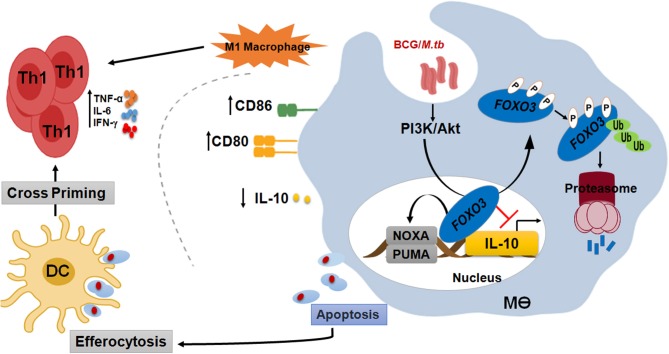
FOXO3, a signaling hub for a protective immune response against mycobacterial infection. In order to compromise host resistance, M.tb predominantly activates the pro-survival pathway PI3K/Akt to inhibit apoptosis and induce IL-10 through FOXO3 inhibition. Activated Akt will then phosphorylate the pro-apoptotic transcription factor FOXO3 at three residues, Thr32, Ser253, and Ser315, leading to its translocation to the cytosol where it is stored as a complex FOXO3/chaperone protein 14-3-3 and/or degraded by the proteasome. However, PI3K/Akt inhibition leads to activation of FOXO3, which will accumulate inside the nucleus and restrict IL-10 secretion through direct binding to its proximal promoter. Inhibition of IL-10 signaling is necessary to restore the anti-mycobacterial capacity of the host and increase the polarization of macrophage toward a proinflammatory M1 phenotype, which is crucial for the shaping of an effective Th1 adaptive response against M.tb pathogenesis. Activation of FOXO3 would also induce the expression of PUMA and NOXA, the two effectors of macrophage apoptosis. Apoptotic bodies charged with mycobacterial antigens will be ingested by the bystander dendritic cells (DC) to better cross-prime T cells. In conclusion, activated FOXO3 in infected macrophages benefit the protection against TB in many ways. (i) Induces apoptosis of infected-macrophages and disrupts the intracellular replication of M.tb within the host. (ii) Inhibits IL-10 and restore the antimicrobial host responses. (iii) Boost the adaptive immune response to M.tb.